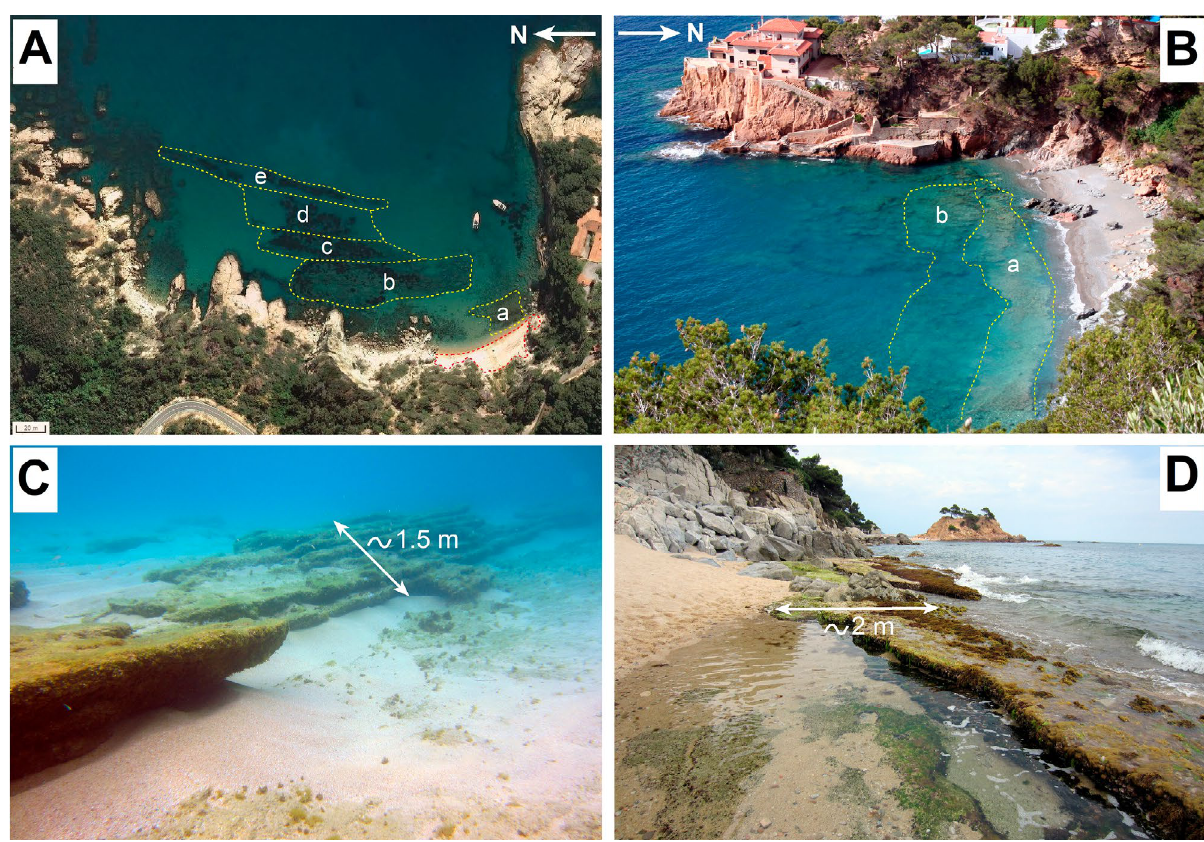
Fig. 3. – Examples of beachrocks. A, vertical view of CA15 beachrocks ledges (a-e) (yellow dot lines) and the current beach (red dot line). B, view of the CA1 beachrock ledges a and b (yellow dot lines); ledge b eastern part is degraded (at the bottom of the image). C, inner layers (upper level of CA14 beachrock). D, partially emerged beachrock (CA11).